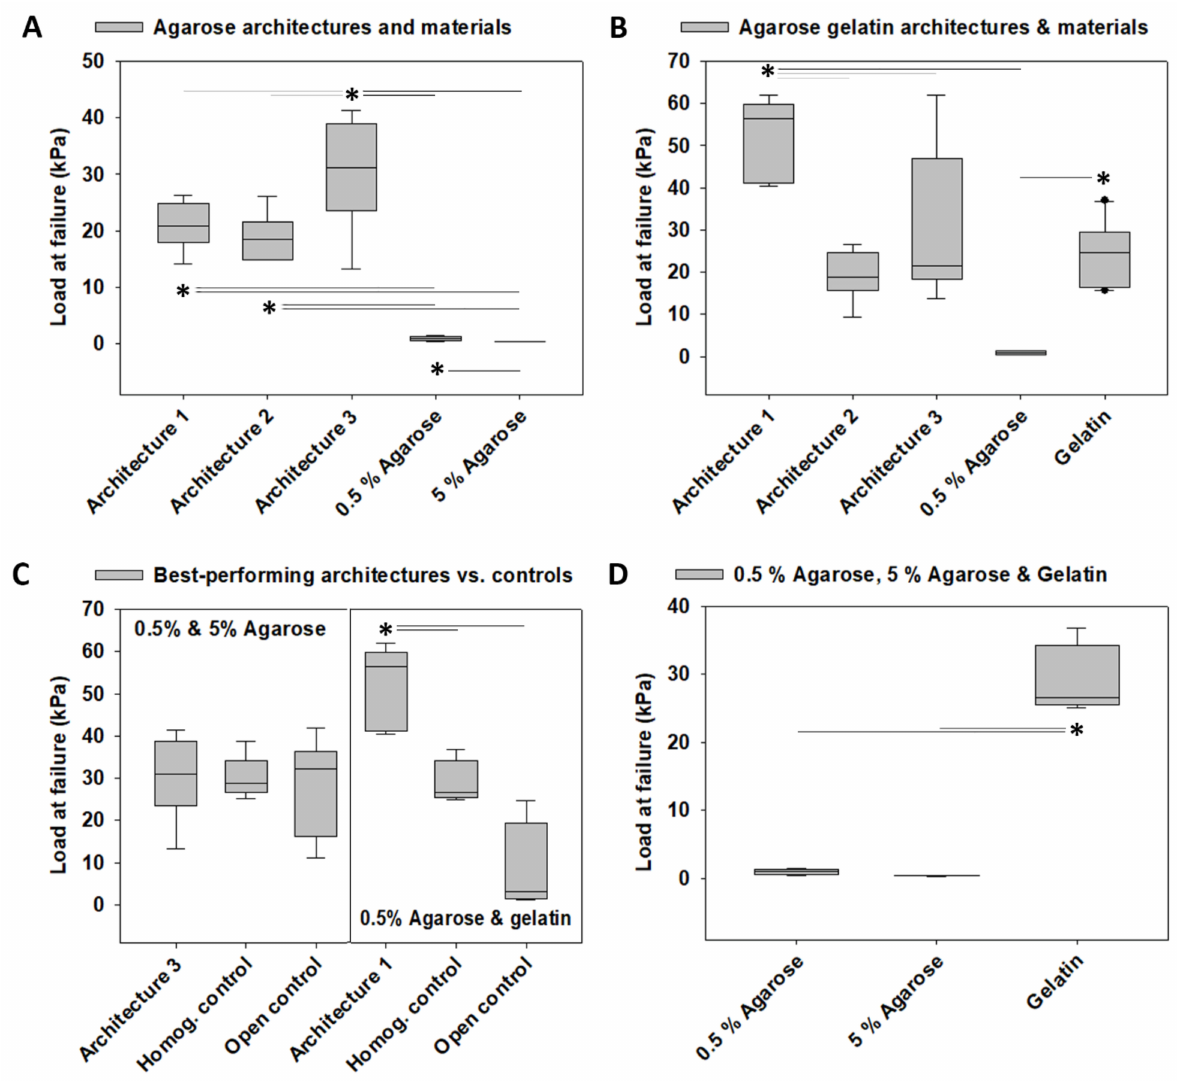
Figure 2. Mechanical characterization of the failure loads of the tested model systems, controls, and materials used for fabrication. ( A ) Failure loads of the architectures 1, 2, and 3 of the 0.5% and 5% agarose model system and of the biomaterials used for fabrication. ( B ) Failure loads of the architectures 1, 2, and 3 of the 0.5% agarose gelatin model system and of the biomaterials used for fabrication. ( C ) Failure loads of the best-performing architecture of both agarose model systems and agarose gelatin model systems determined in ( A , B ) as well as their associated homogeneously mixed controls and open controls. Those were fabricated by cutting the stiff rings of architecture 1 into pieces and distributing them within the softer biomaterial, leading to an unconfined situation. ( D ) Failure loads of all individual materials used for model system fabrication. The box plots give the median and the 25th and 75th percentiles, the whiskers give the 10th and 90th percentiles, and the round symbols, if present, indicate outliers. The dark gray lines and the asterisks (*) indicate differences at p < 0.05 identified in ANOVA or ANOVA on ranks and pairwise multiple comparison procedures, such as the Newman–Keuls or Dunn’s method. Light gray lines and the asterisk (*) indicate differences at p < 0.05 that were identified with the same statistical tests, in which only architectures 1, 2, and 3 were compared. Number of 0.5% and 5% agarose homogeneous controls: n = 5, number of all other 0.5% and 5% agarose samples: n = 6, number of gelatin material samples: n = 10, number of all other 0.5% agarose and gelatin samples: n =